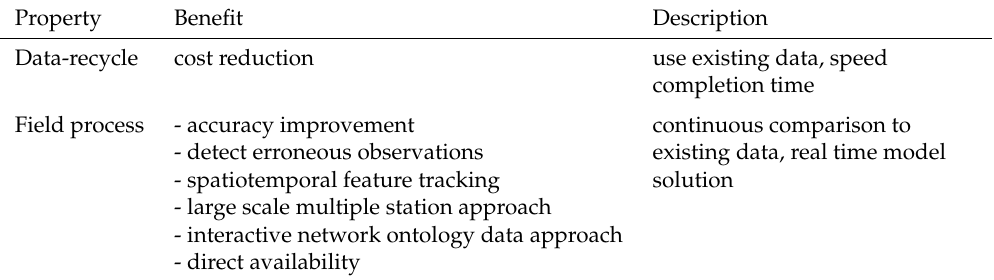
Table 2: Potential benefits.